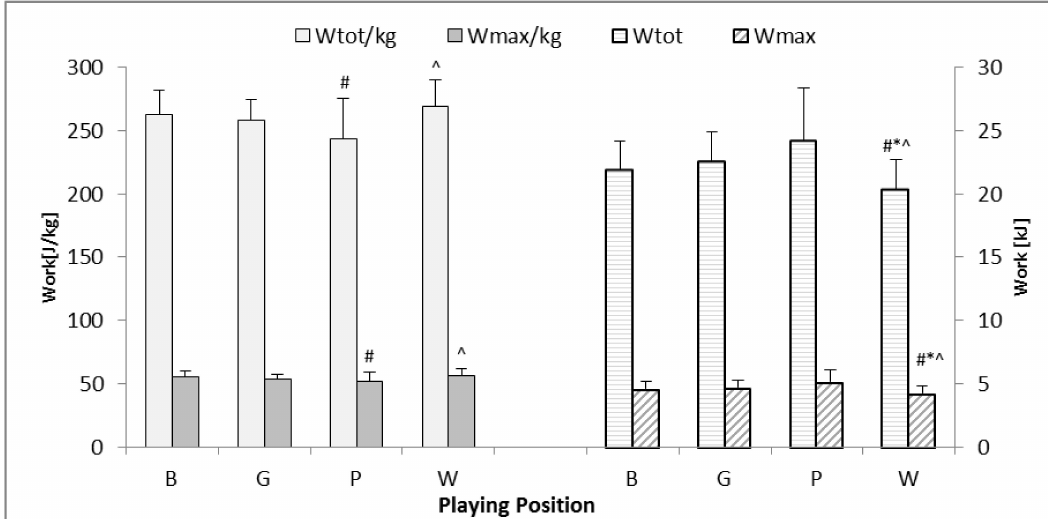
Figure 2. Di ff erences in absolute maximal work (W max ) and total work (W tot ) as well as relative maximal work (W max / kg ) and total work (W tot / kg ) in the RSA test for athletes of various playing positions. B—backs, G—goalkeepers, P—pivots, W—wings, #—significantly di ff erent from B, *—significantly di ff erent from G, ˆ—significantly di ff erent from